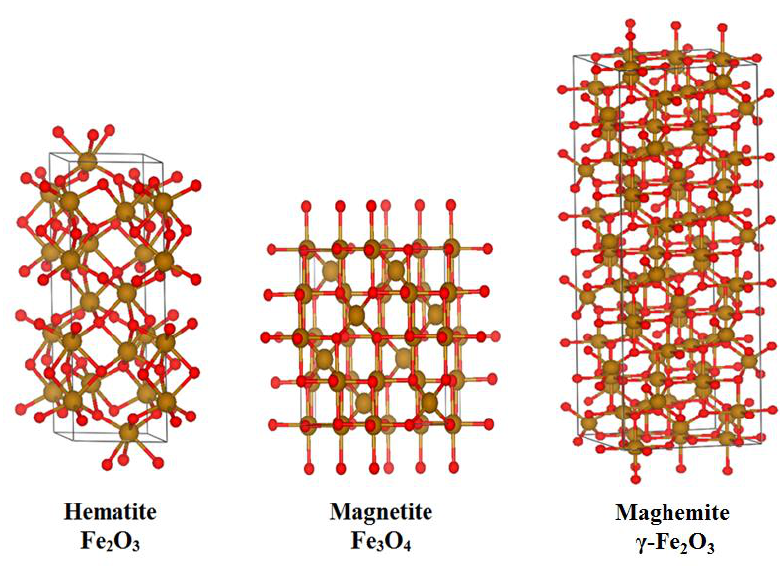
Figure 1. Possible crystal structures of the Superparamagnetic Iron Oxides Nanoparticles (SPIONs).